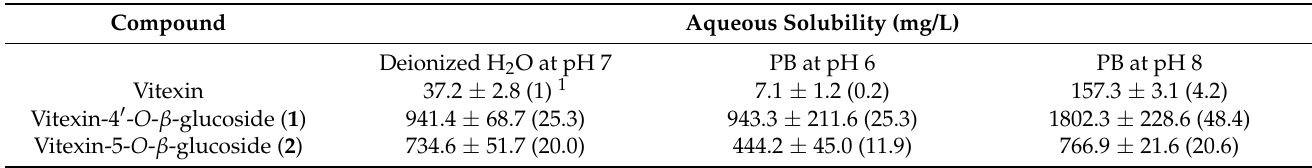
Table 2. Aqueous solubility of vitexin and its derivatives at different